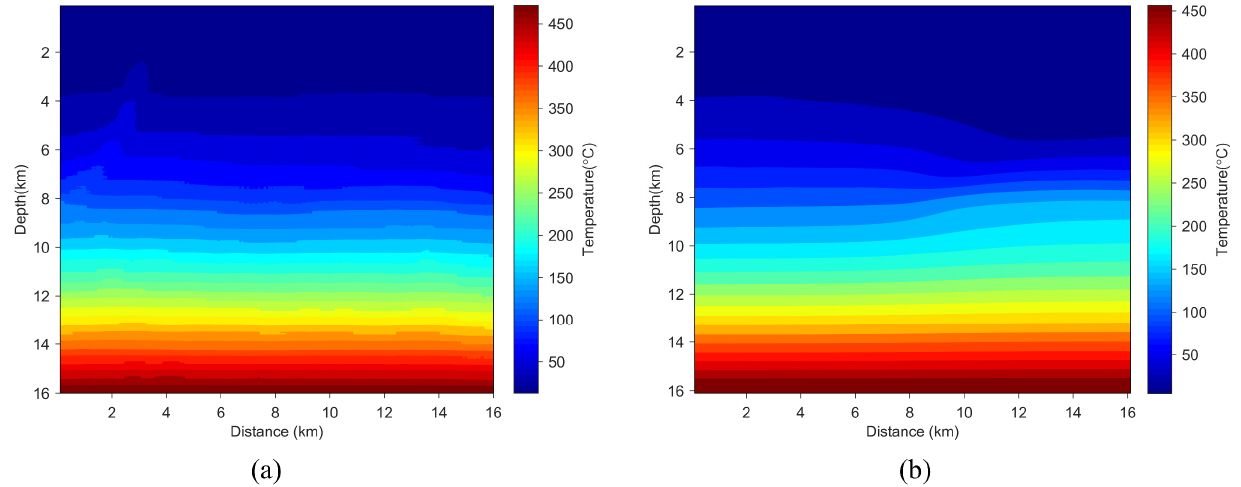
Figure 11. Temperature simulation comparison of the second model. ( a ) Temperature field simulated by the HDRT–UNet; ( b ) Temperature field simulated by the finite element method.